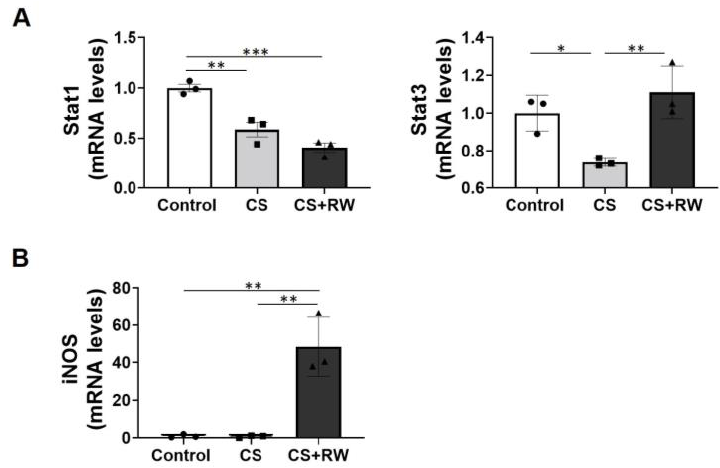
Figure 5. In vitro cold storage and/or rewarming dysregulates the expression of STAT1, STAT3, and iNOS in rat renal cells. NRK cells were exposed to either 18 h CS or CS + RW (re-warming; 6 h). Quantitative real-time PCR (SYBR Green) was performed to assess ( A ) STAT1, STAT3, and ( B ) iNOS after CS or CS + RW. Data are the mean ± SEM (bars, n = 3) and comparisons were made via 1-way ANOVA followed by Brown – Forsythe and Welch’s correction for mul tiple group comparisons; p < 0.05 was considered significant between Control vs. CS + RW and CS vs. CS + RW groups. *, p < 0.05; **, p < 0.01, ***, p < 0.001. Each solid circle, square, or triangle represent individual animal within the group.